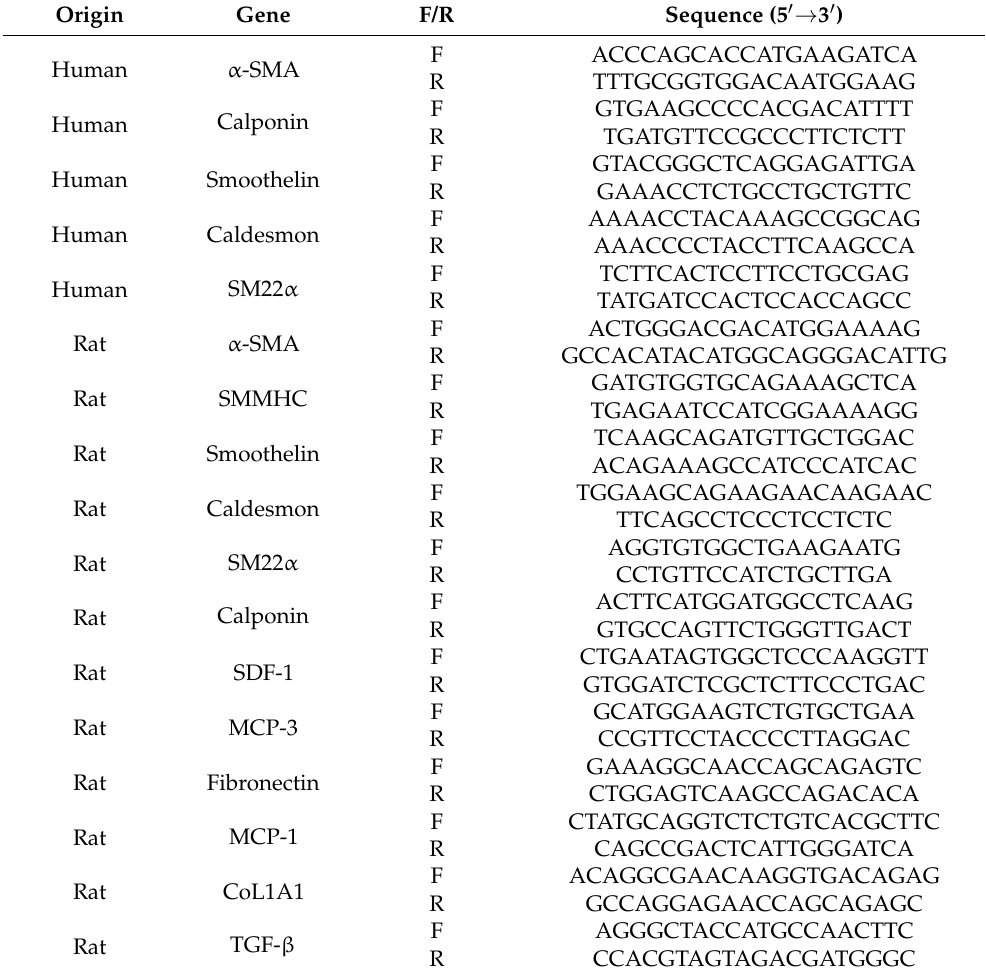
Table 1. Primers for smooth muscle cells derived from human adipose stem